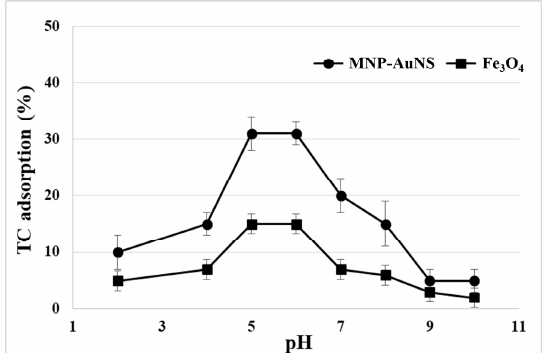
Figure 6. Effect of pH of the medium on the TC uptake, for an initial TC concentration of 10 μ M and a contact time of 20 min.